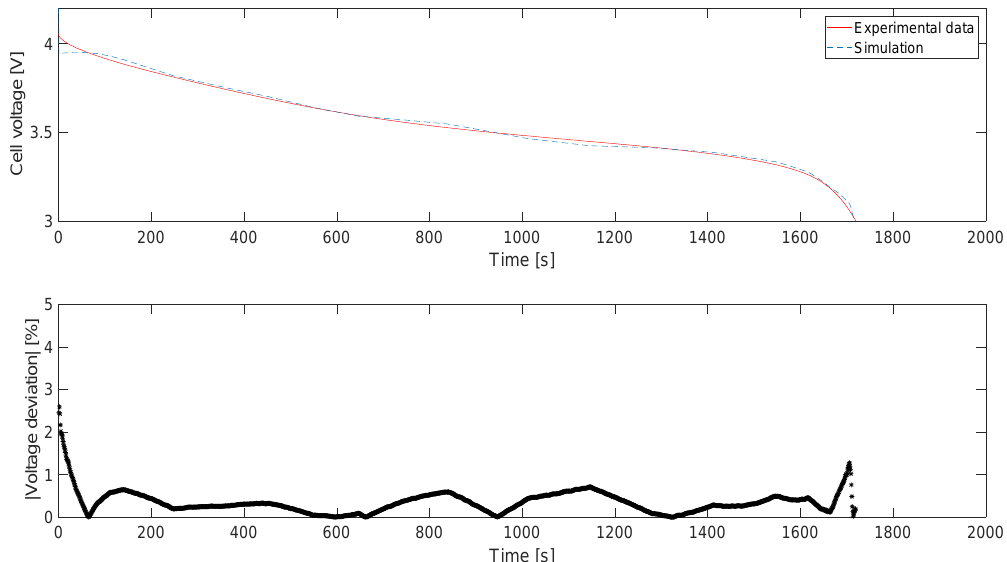
Figure 19. ( Upper ) Cycled cell voltage during high constant current discharge at 35 ◦ C cycling temperature; ( Lower ) Absolute value of the voltage deviation between experimental and simulations